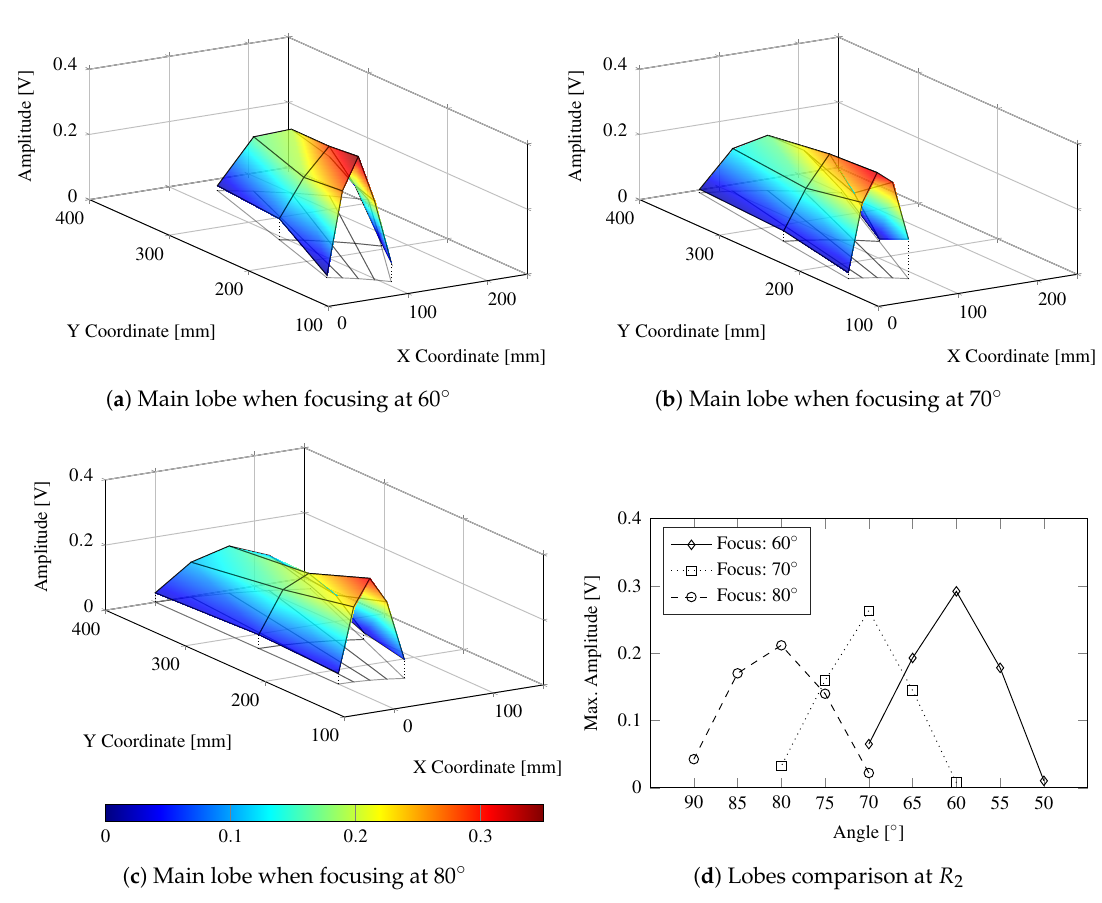
Figure 9. Graphical representation of the main lobes generated by the beamforming technique at three different directions: 60 ◦ , 70 ◦ , and 80 ◦ in panels ( a – c ), respectively. The color bars represent the voltage when the main beam crosses each radius. The PWAS used at the three radius and different angles are represented by the intersections of the radial mesh of the horizontal plane. A comparison of the lobes’ width at R 2 is shown in panel ( d